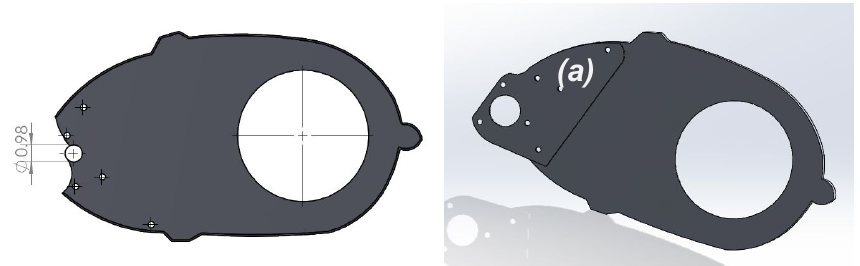
Figure 8. The driving motor gearbox modification. All units are in the metric system. ( a ) The custom-designed support fixture for the driving motor